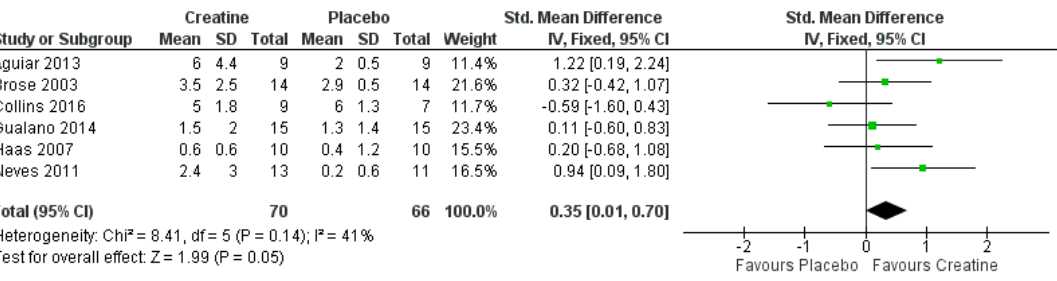
Figure 2. Forest plot for sit-to-stand performance. SD = Standard Deviation; CI = Confidence Interval. The large diamond on the Forest plot indicates the mean effect across studies. The effect is significant if the diamond does not cross the “zero” point on the x-axis.